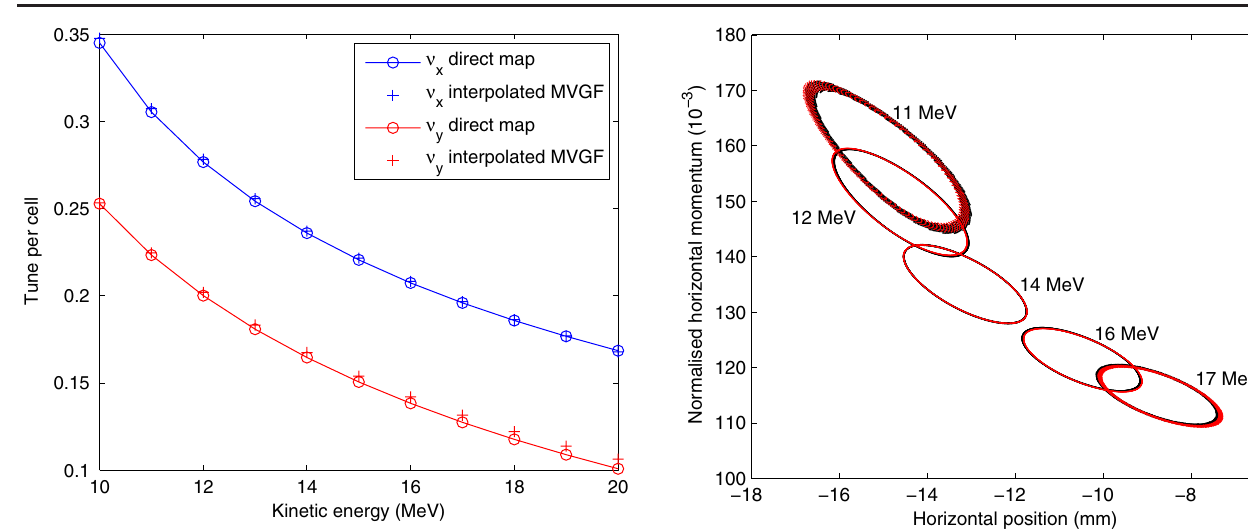
FIG. 15. Betatron motion with multiple transfer maps of order eight, for five energy deviations with 14 MeV reference energy. For the computed map (black) and the map derived from an interpolated MVGF (red), effects of a symplectic error are apparent for energy deviations of 3 MeV